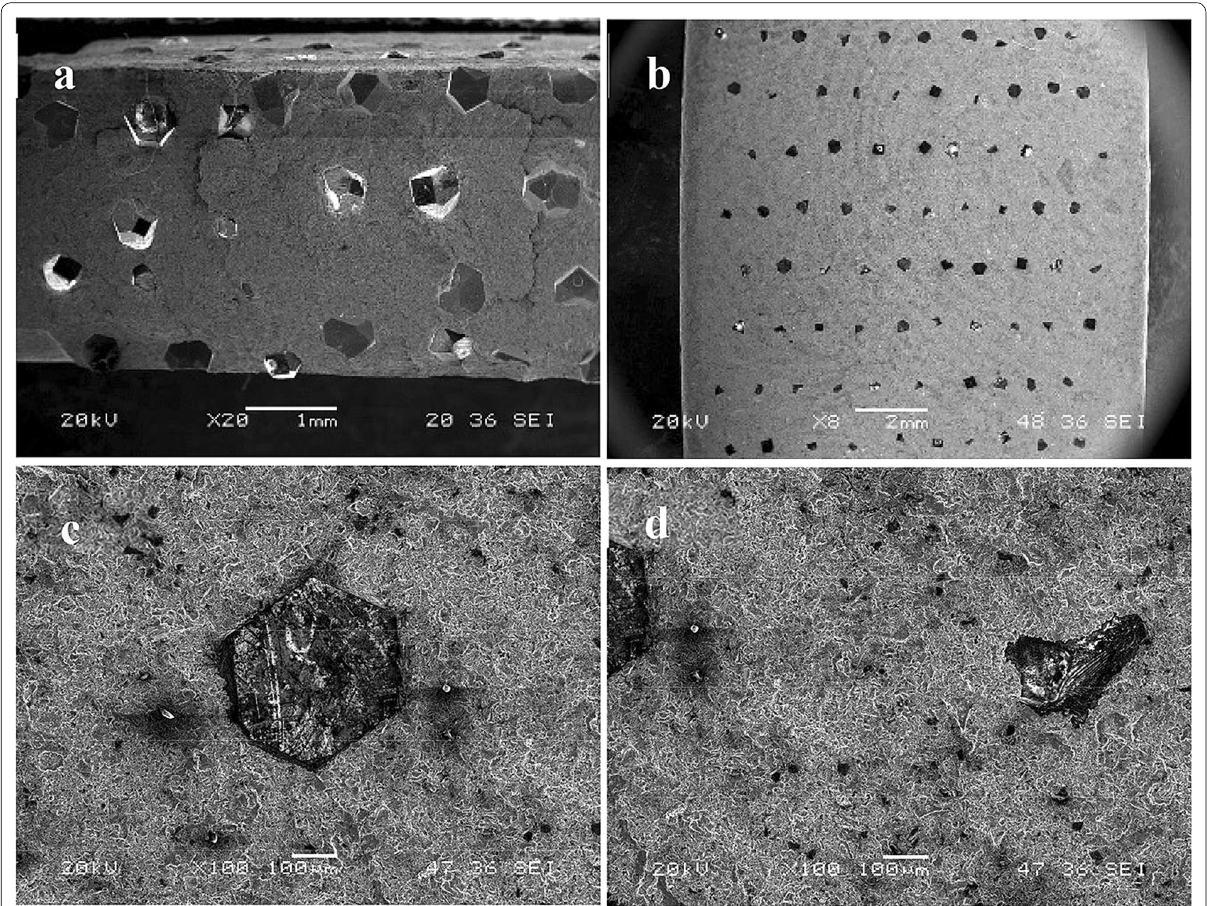
Figure 9 Morphology of used diamond drill with 3D lattice of diamond grits: a fracture surface; b surface layer after grinding; c regular grit in b after grinding; d broken grit in b after